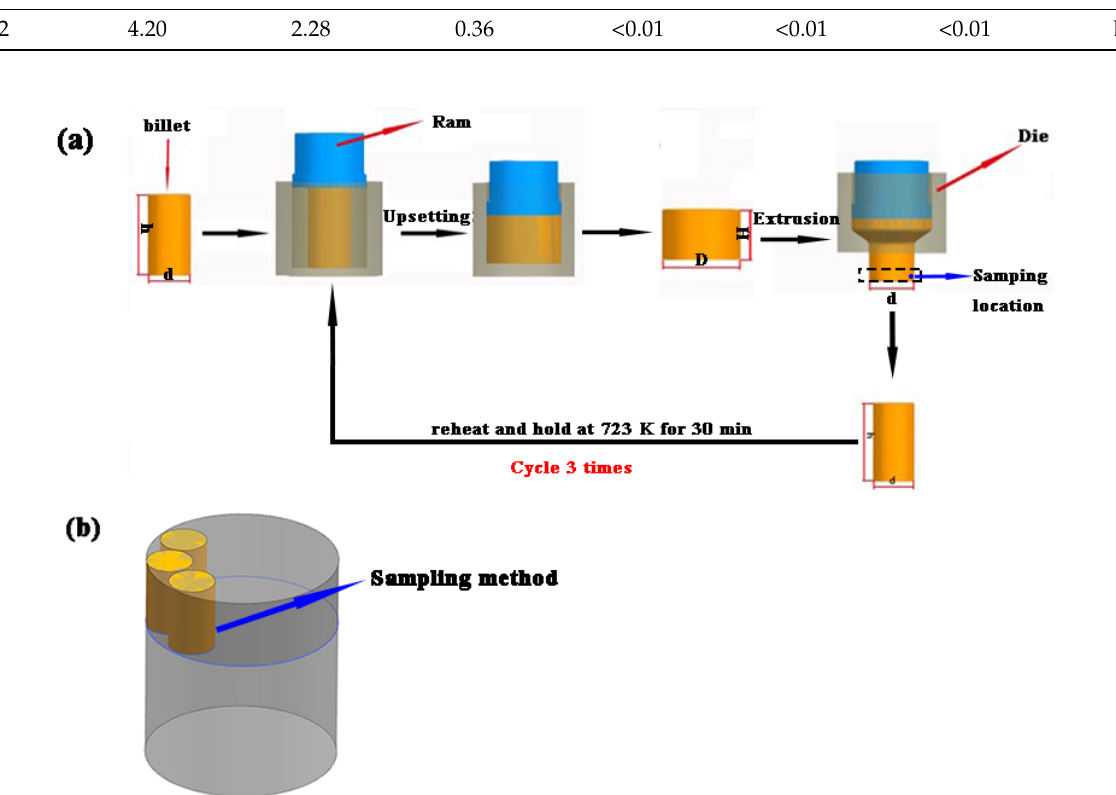
Figure 1. Preparation of materials: ( a ) Principle of RUE experiment; ( b ) The sampling method and position after the repetitive upsetting and extrusion (RUE).